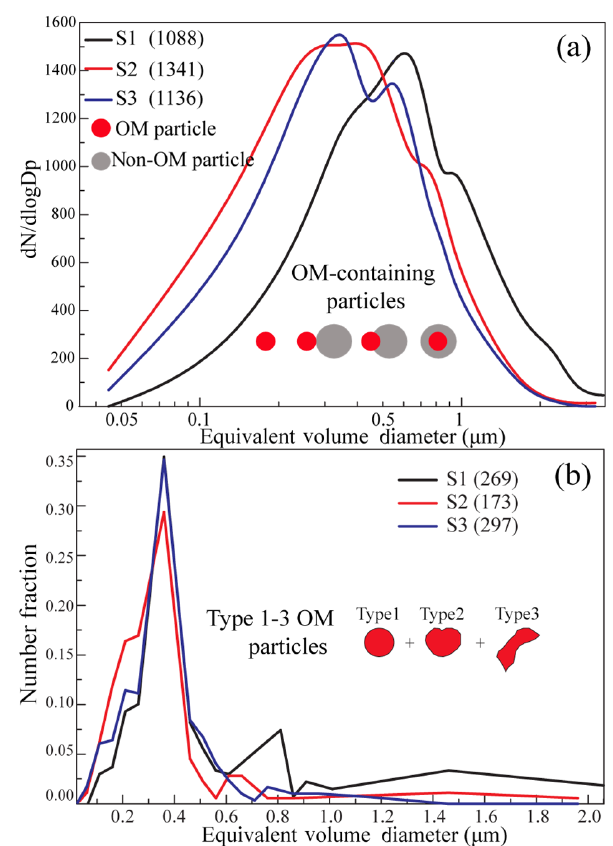
Figure 7. Size distributions of OM-containing particles and OM particles during L & M haze episodes. (a) Size distributions of 1088, 1341 and 1136 OM-containing particles collected at S1, S2, and S3 in all haze episodes during sampling period. (b) Size distributions of 269, 173, and 297 type 1–3 OM particles collected at S1, S2, and S3 in one haze episode during 14–15